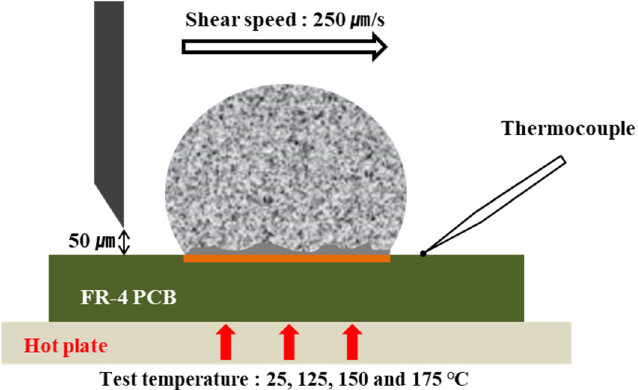
Figure 4. Schematic diagram and test conditions for the shear tests.